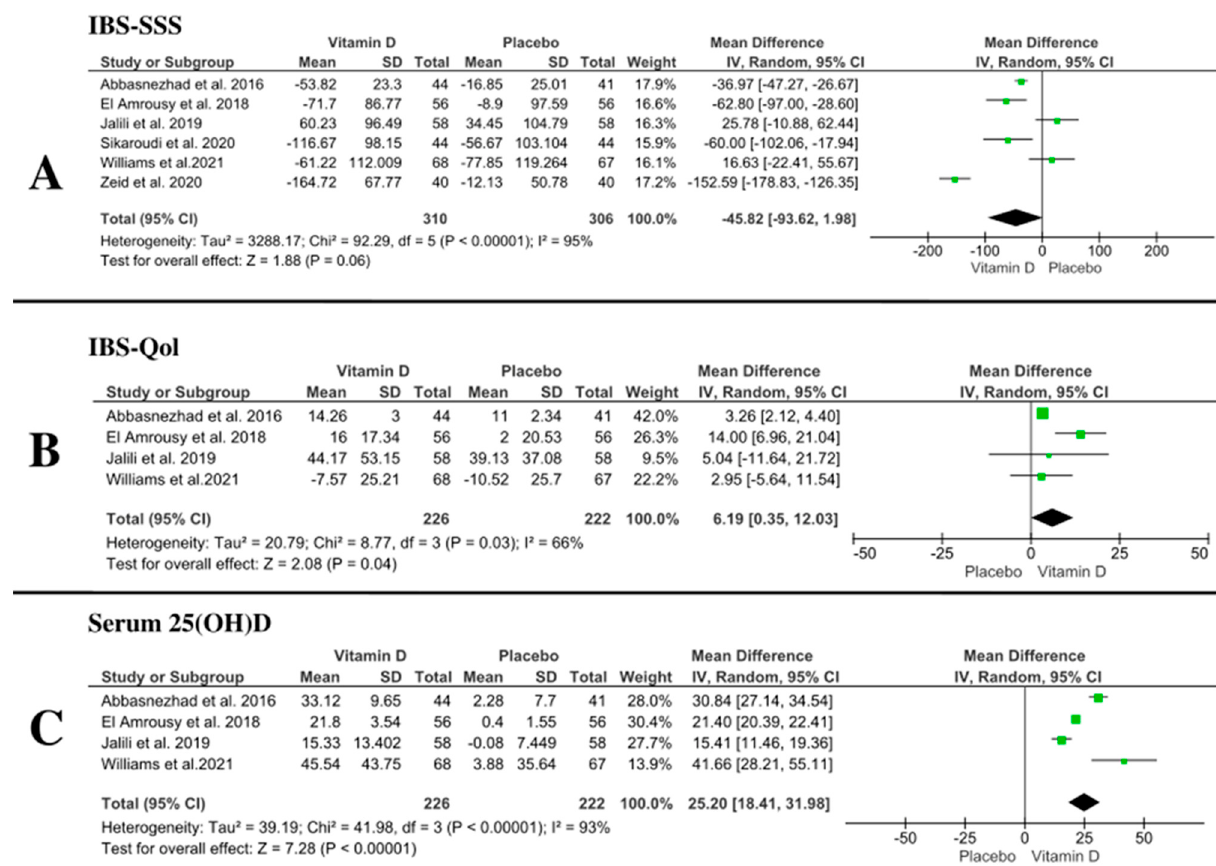
Figure 3. Forest plot of the included outcomes (( A )—IBS-SSS, ( B )—IBS-Qol, ( C )—serum 25(OH)D). I2: I-squared; CI: confidence interval Table 4. Sensitivity analysis.